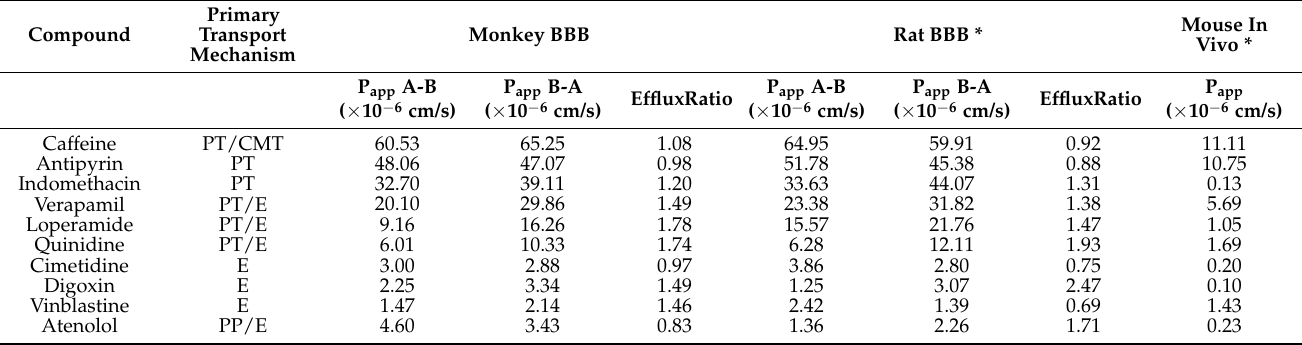
Table 2. BBB permeability parameters measured in monkey and rat in vitro models and in mouse in vivo.